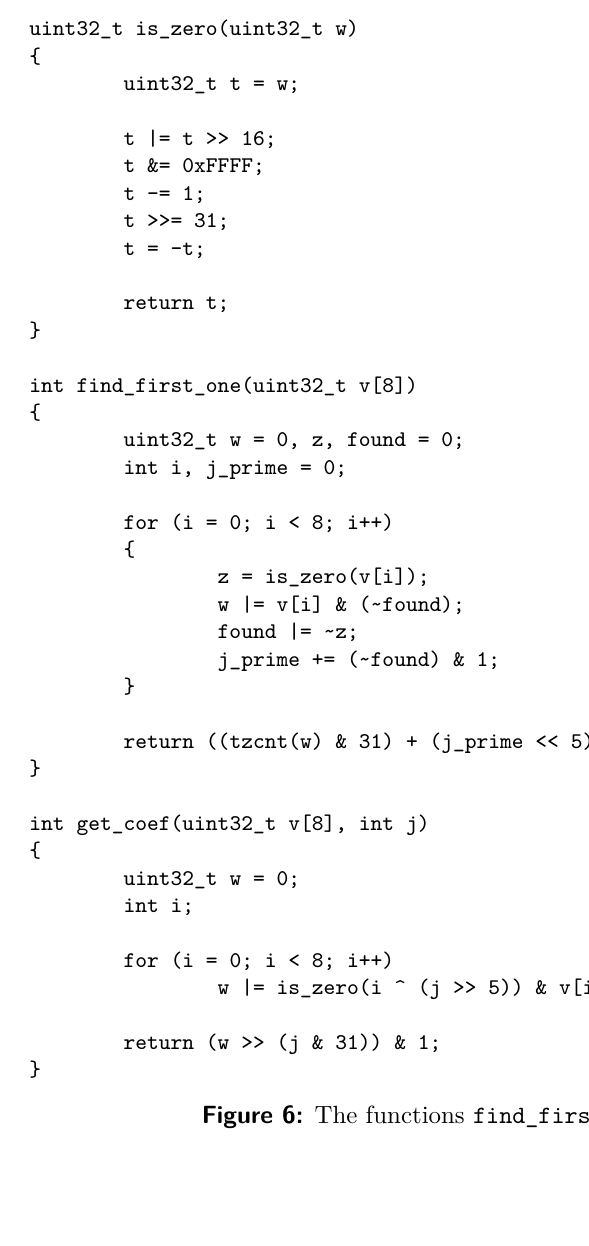
Figure 6: The functions find_first_one and get_coef